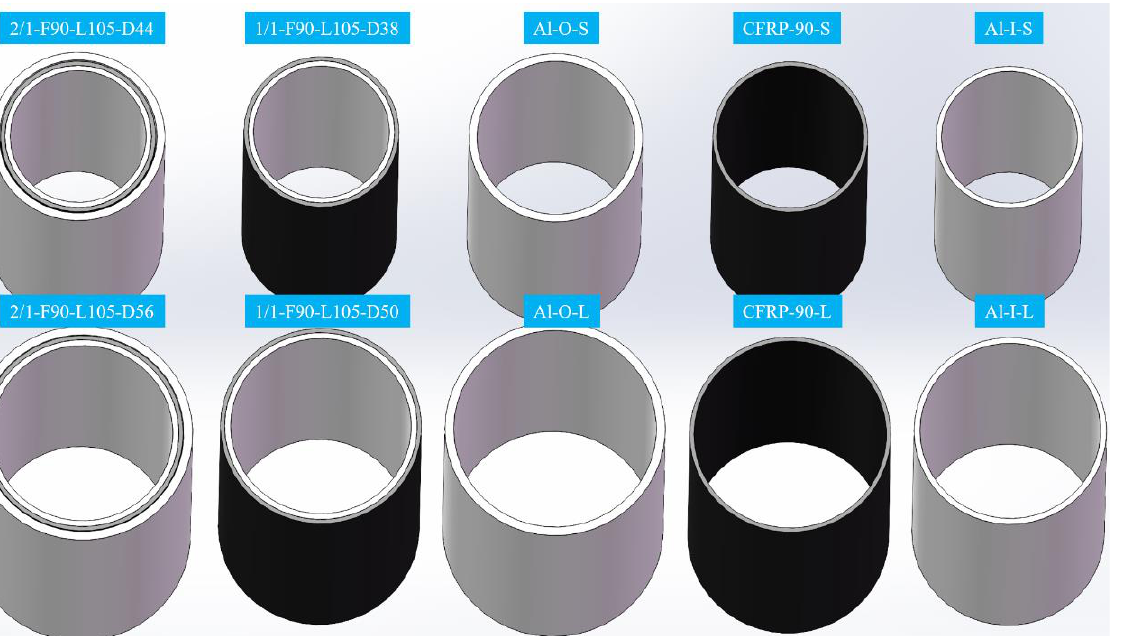
Figure 1. Two types of aluminum/CFRP hybrid tubes and three kinds of corresponding individual tubes.